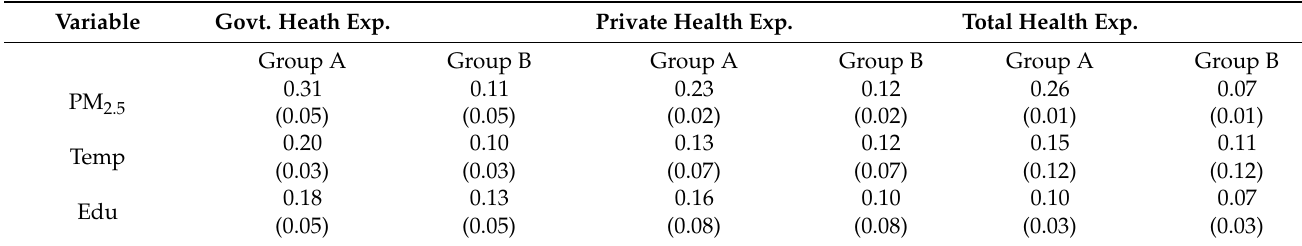
Table 5. Comparative Results of Higher-& Lower-Income